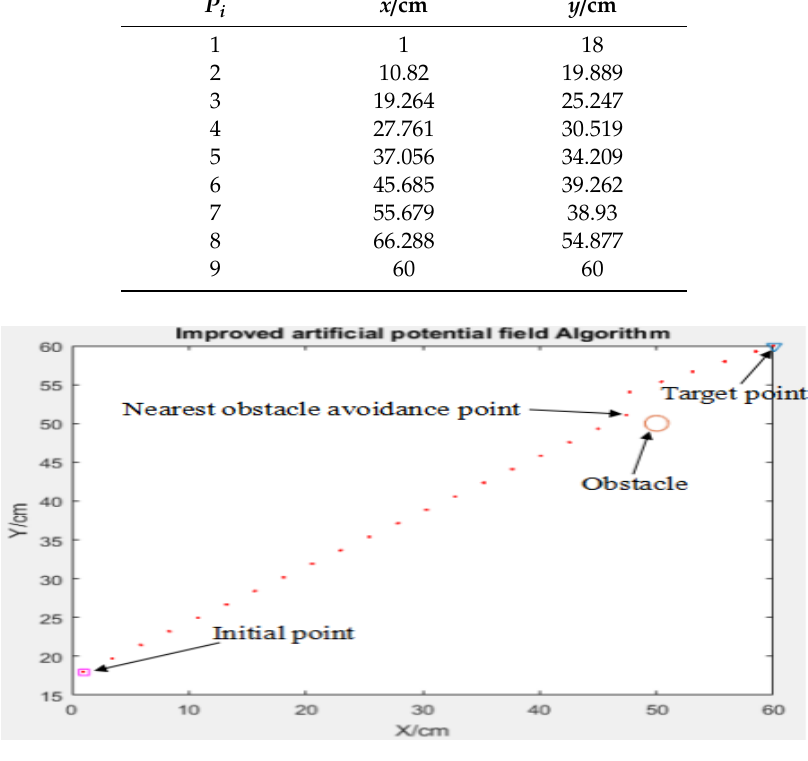
Figure 12. Trajectory planning of the improved artificial potential field method. Appl. Sci. 2020 , 10 , 935